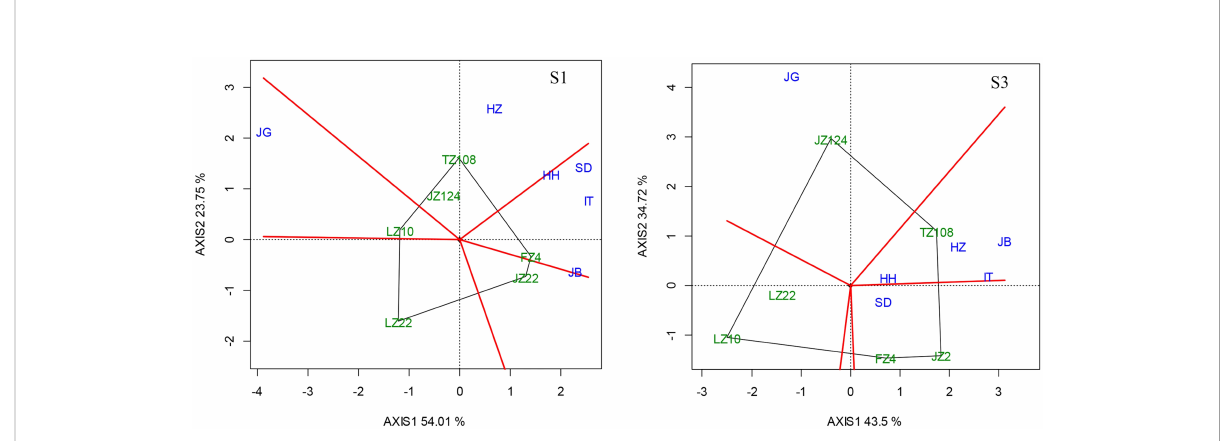
FIGURE 11 “ Which Won Where/What ” biplot under different sowing dates (Left, early sowing, S1; Right, late sowing,